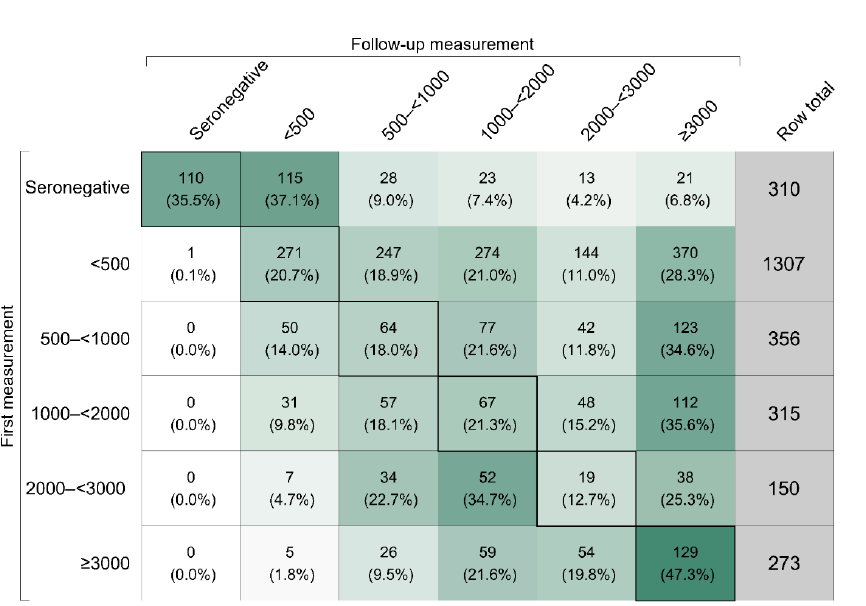
Figure 1. Percentage of participants in categories of anti-S IgG antibody levels in Binding Antibody Units per milliliter between October 2021 and April 2022. Seronegativity corresponds to anti-S IgG levels < 7.1 Binding Antibody Units per milliliter. The analysis involved data on 25,561 measurements taken from 22,607 individuals.